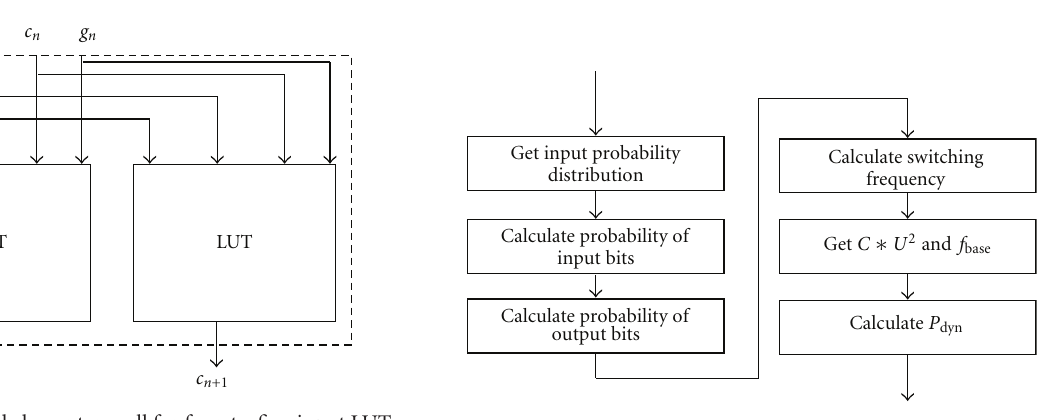
Figure 8: The high-radix adder with gate mapped to LUTs.